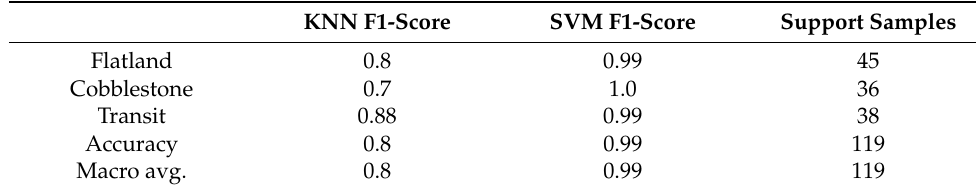
Table 4. KNN performance